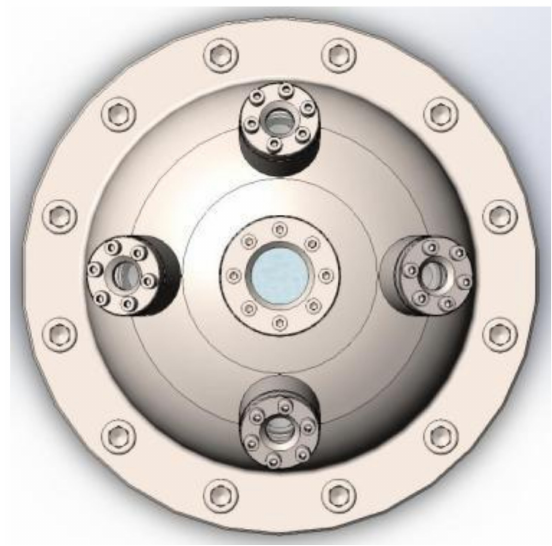
Figure 5. Schematic diagram of reactor